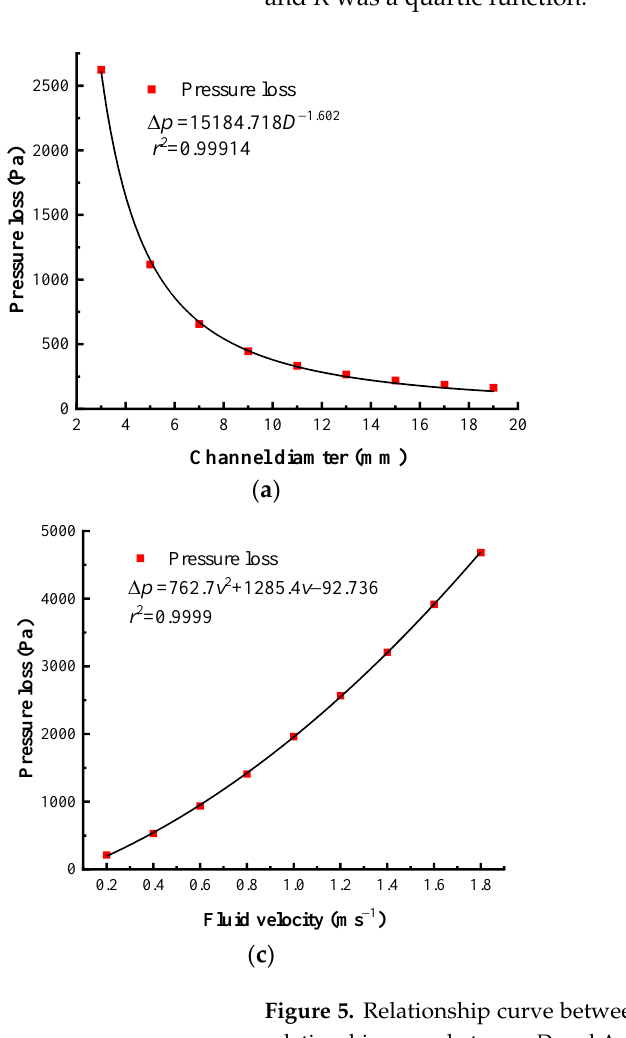
( b ) Figure 6. Correction curve for the relationship between curvature radius and pressure loss: ( a ) rela- tionship curve between R and  p ( R / D ≤ 11); ( b ) relationship curve between R and  p ( R / D > 11). 4.2. Relationship between Design Parameters of Flow Channels and Pressure Loss From the analysis in Section 4.1, it can be seen that the design parameters of the flow channel had an important influence on the pressure loss. The influence degree of each parameter on the pressure loss was different, and there were interactions. These interac-